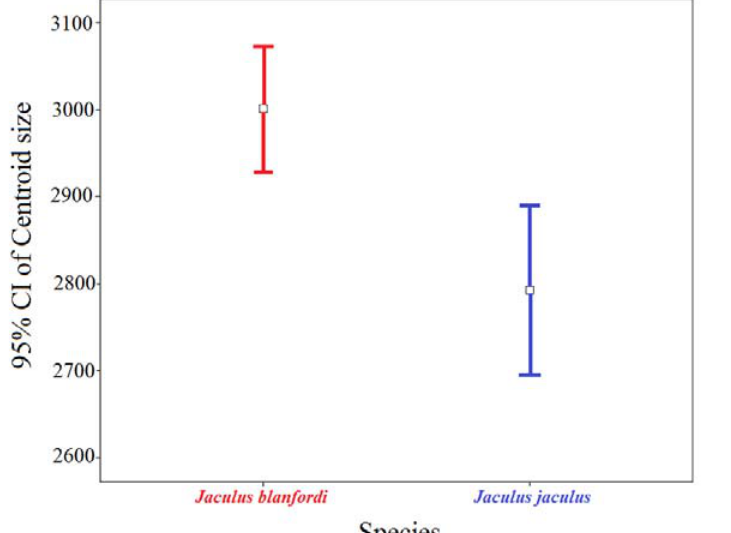
F IGURE 5 . The ratio chart of whole morphometric characters which indicate all of measured variable in J.jaculus are smaller than J.blanfordi